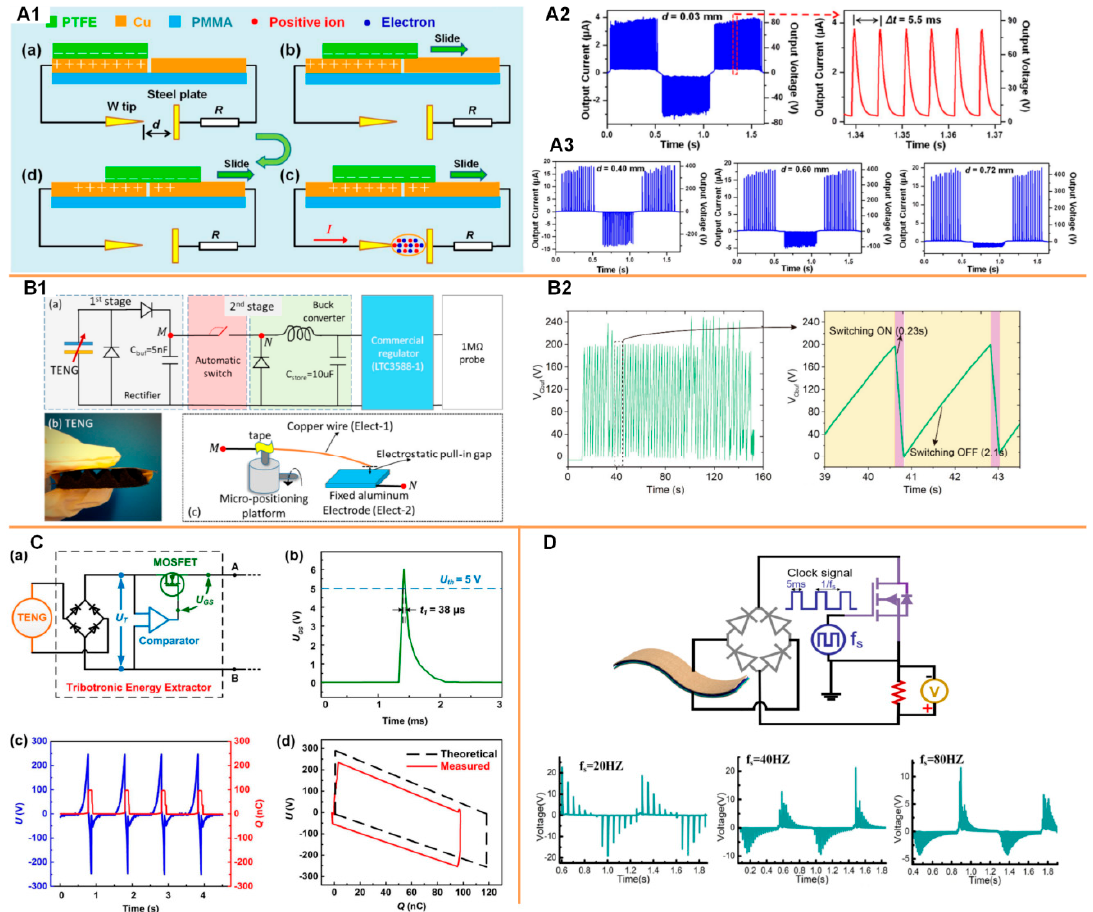
Figure 7. The high-frequency automatic switching methods applied to TENG devices. ( A ) Plasma-based switching method: ( A1 ) The plasma generated between the needle-plate by a sliding TENG device; ( A2 ) The typical current / voltage of the generated plasma; ( A3 ) The asymmetric changing trend of the plasma initiated from the needle (positive) and the plate (negative). Reproduced with permission Schematics of the system configuration for the generation of a stable DC output ( b ) The TENG device used in the system; ( c ) the method of the electrostatic automatic switching; ( B2 ) The current pulses generated by the electrostatic automatic switching. ( C ) MOSFET-based auto-switching